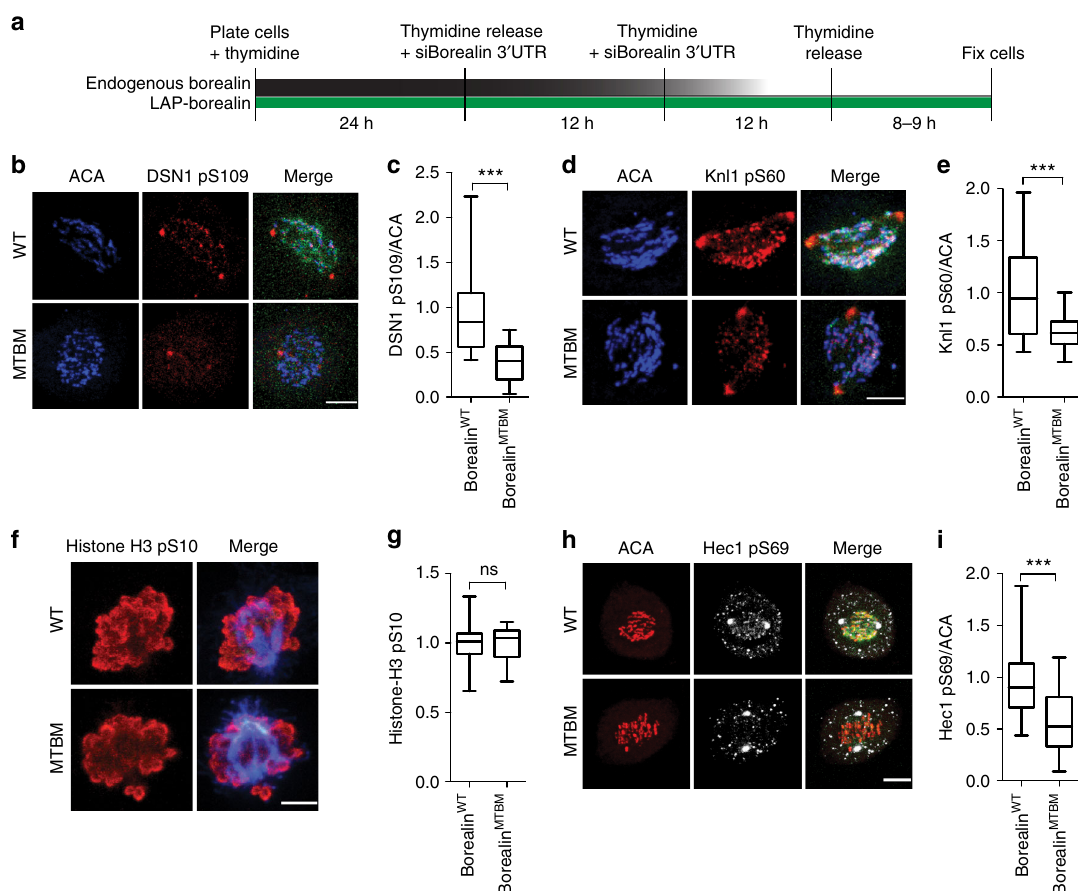
Fig. 5 Borealin-microtubule interaction contributes to robust phosphorylation of the kinetochore substrates by the CPC. a Schematic of Borealin siRNA mediated knockdown rescue experiment. HeLa-TReX cells stably expressing LAP-Borealin WT or MTBM were treated with Borealin 3 ’ UTR siRNA and cells were immunostained in fi rst mitosis after knockdown of endogenous Borealin. Kinetochore phosphorylation was assessed by immunostaining with b DSN1 pS109, d Knl1 pS60, h Hec1 pS69, antibodies. Green color in merge images indicates LAP-Borealin localization. f Chromatin phosphorylation was assessed by immunostaining with histone H3 pS10. Box and whisker graphs of normalized intensity from c DSN1 pS109 ( n = 103 (from 8 cells) for WT and n = 73 (from 9 cells) for MTBM), e Knl1 pS60 ( n = 61 for WT and n = 72 for MTBM, from eight cells per condition), g H3 pS10 ( n = 18 for WT and n = 11 for MTBM) and i Hec1 pS69 ( n = 68 (from 7 cells) for WT and n = 73 (from 6 cells) for MTBM, from at least six cells per condition), staining. All representative immuno fl uorescence images and quantitation data are from 1 of 2 independent repeats. Statistical analysis was performed using Mann Whitney Test, *** P < 0.0001 and ns P > 0.05. All Box and whisker plots represent the median (central line), 25th – 75th percentile (bounds of the box)